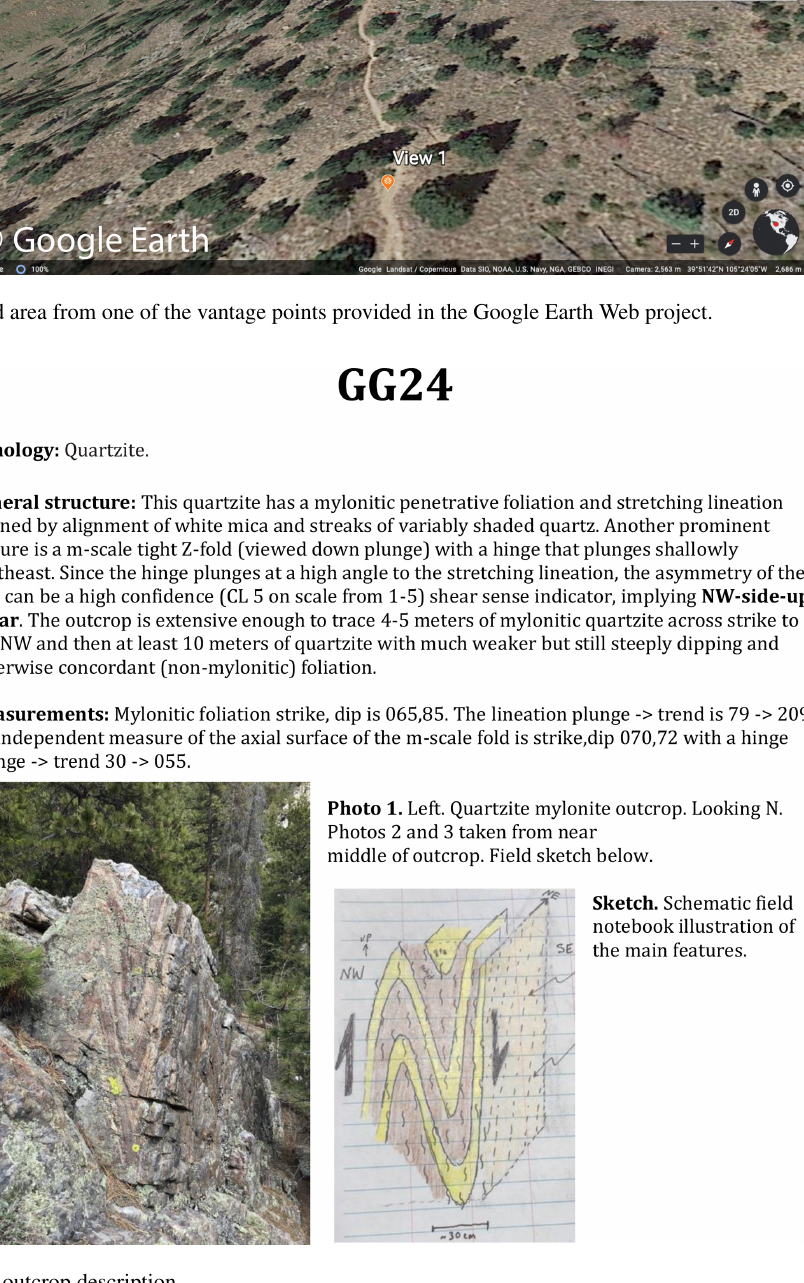
Figure 4. Part of a typical outcrop